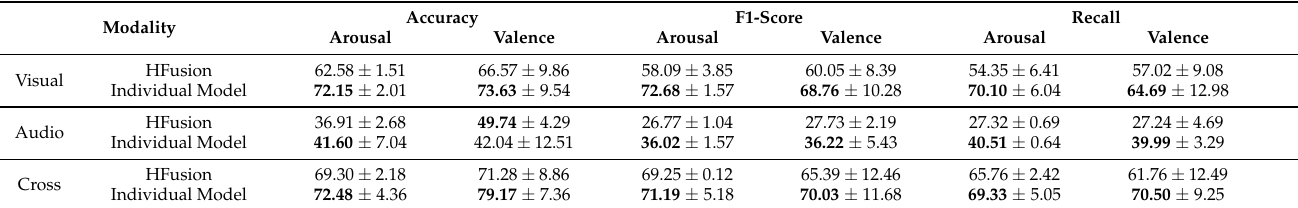
Table 2. Comparison in terms of accuracy, f1-score, and recall of HFusion [59] with our individual models for visual, audio, and cross-modality.